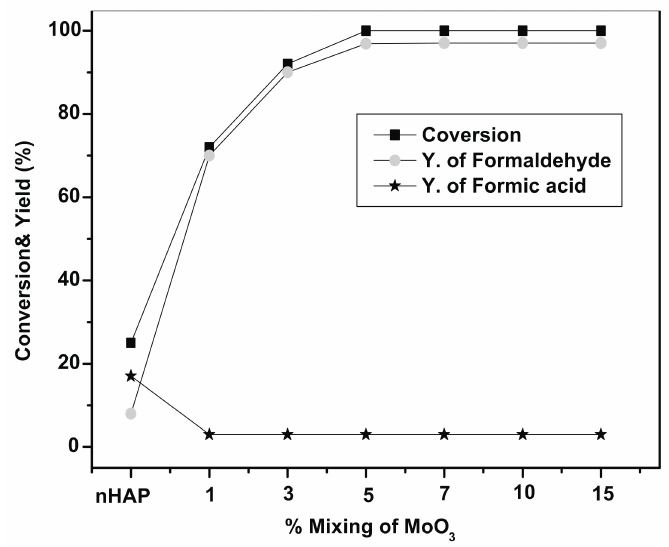
Figure 18. Conversion of MeOH and FA yield as function of MoO 3 loading on HAP. Reprinted by permission from [108] Springer, Catalysis Letters, Copyright © (2015).